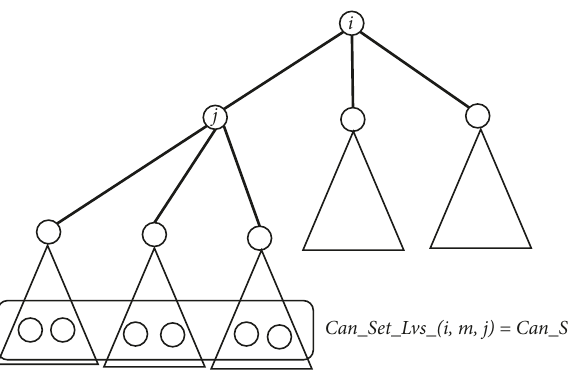
Figure 2: The candidate set of leaves 𝐶𝑎𝑛 𝑆𝑒𝑡 𝐿 V 𝑠(𝑖,𝑚, 𝑗) in the subtree 𝑇 𝑖 𝑗 .